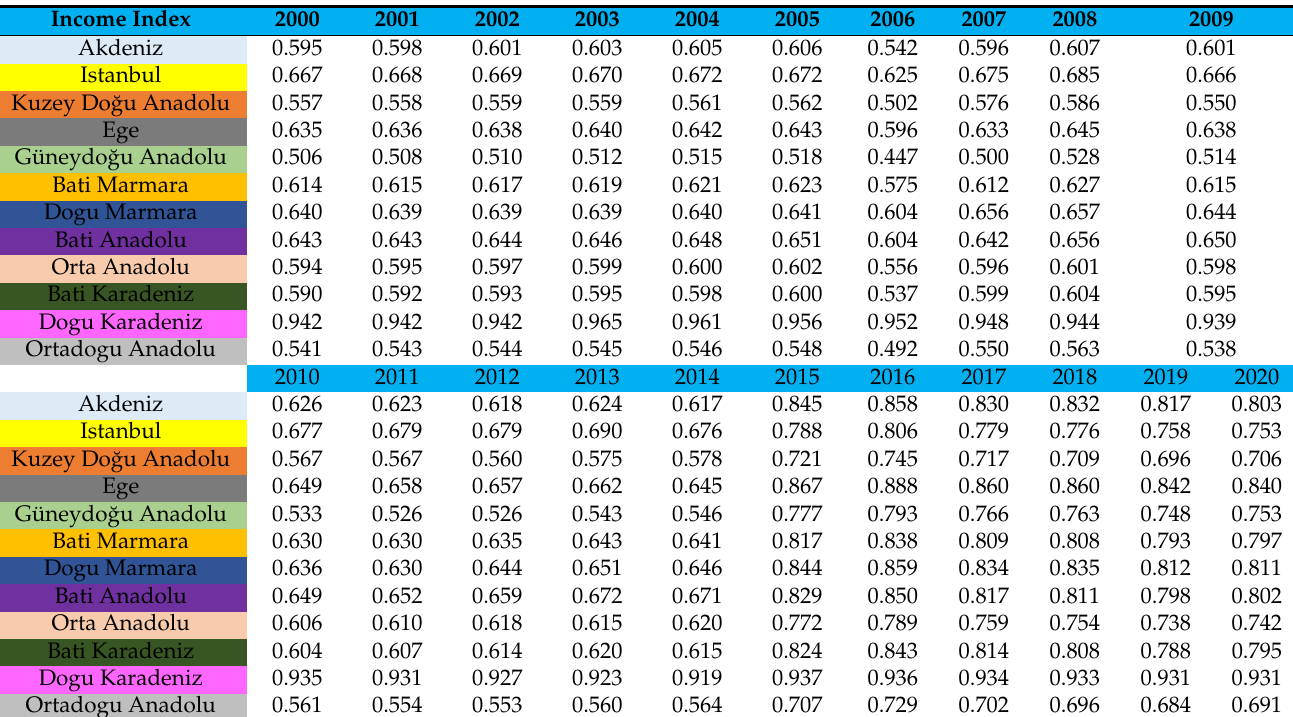
Table 16. Estimated income index—Turkey